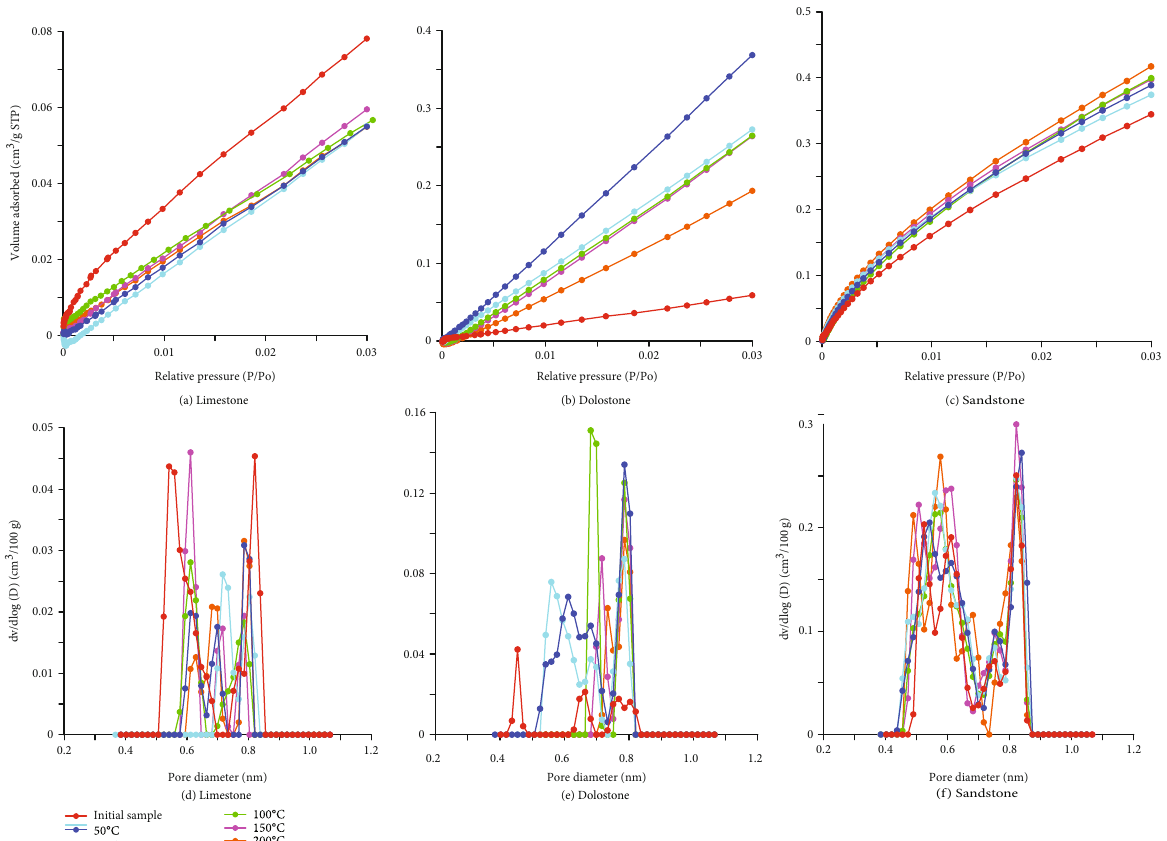
Figure 9: CO adsorption isotherms for initial and altered rock grains ((a) limestone series, (b) dolostone series, and (c) sandstone series) and 2 pore volume distribution with pore size derived from CO adsorption isotherms using the DFT model ((d) limestone series, (e) dolostone 2 series, and (f) sandstone series). Note that numerical scales di ff er among the y